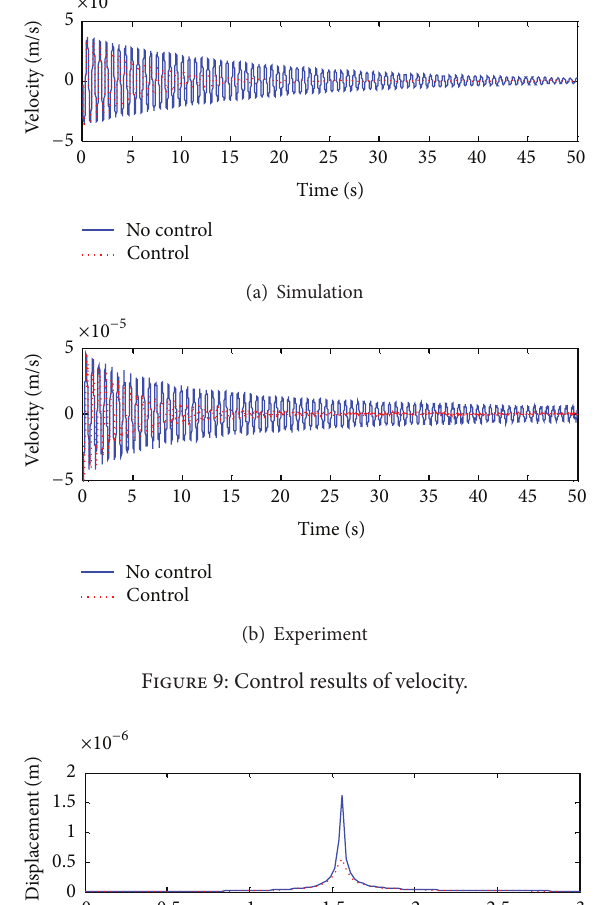
shows the spectrum analysis of velocity without control and with control with experiment. In addition, the peaks with no control and with control are 1.5060 × 10 −5 m/s and 5.8273 × 10 −6 m/s, respectively. Therefore, it is obvious that the reduced amplitude quantities of velocity are 61.31% in